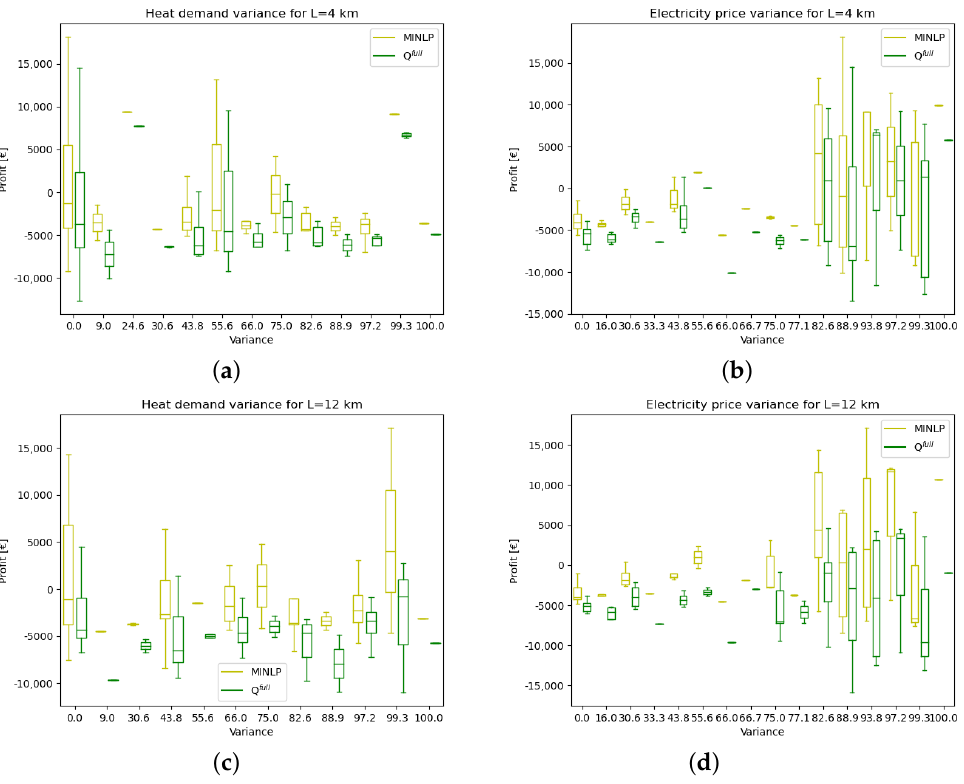
Figure 5. ( a ) Heat demand variance for L “ 4 km. ( b ) Electricity price variance for L “ 4 km. ( c ) Heat demand variance for L “ 12 km. ( d ) Electricity price variance for L “ 12 km.